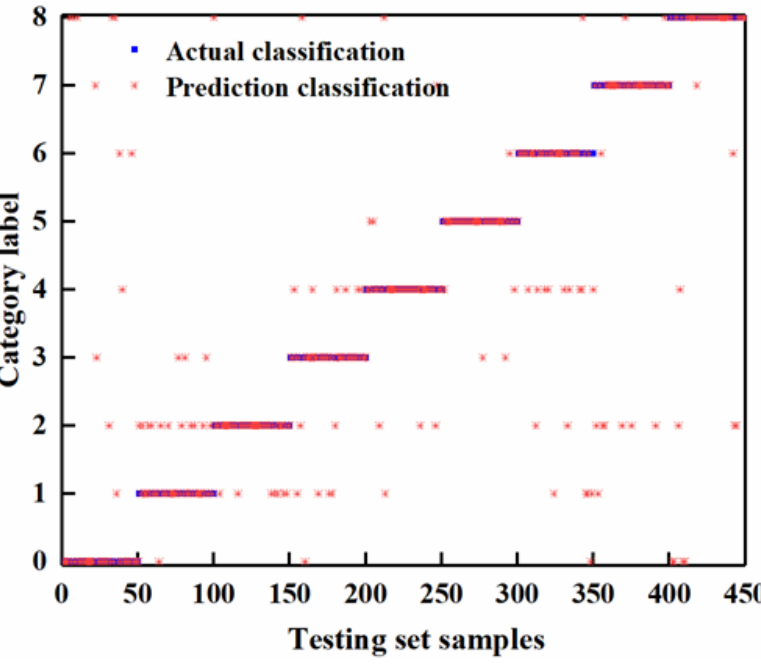
Figure 5. Predictive classification results of ELM algorithm.